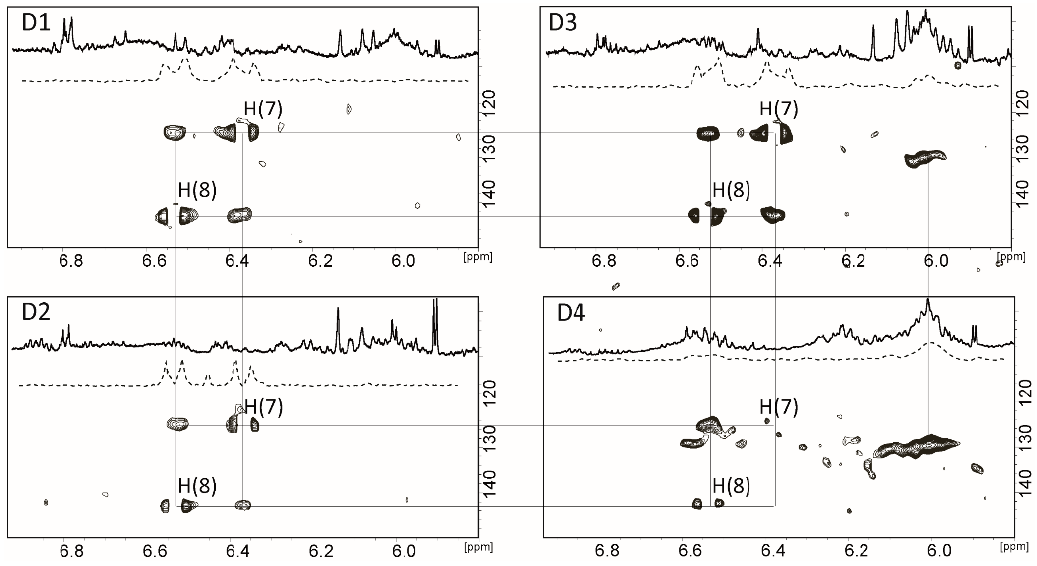
Figure 4. 1 H and 1 H- 13 C HSQC spectra of acetone extracts of salmon hepatocytes at 300 K. The dashed spectra represent the 1D projections of 1 H- 13 C HSQC